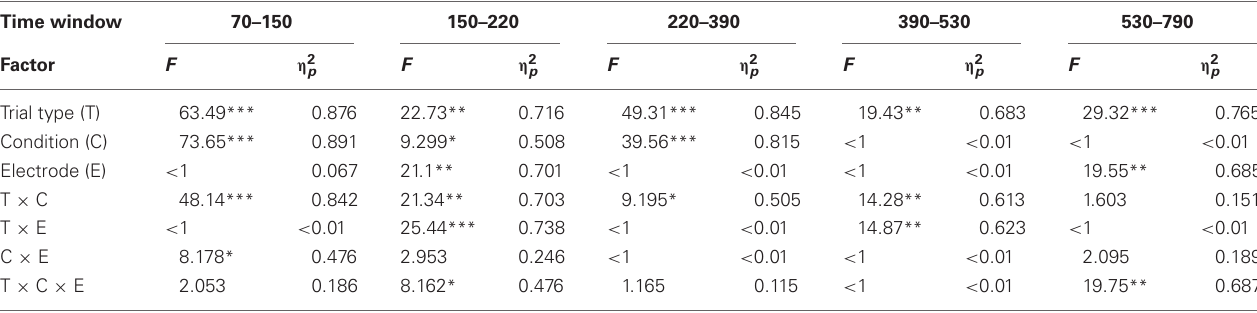
Table 2 | Statistical evaluation of effects of Trial type (rare vs. frequent), Condition (Oddball vs. Distractor), and Electrode (Fz vs. Cz) by means of repeated-measure ANOVAs separately for the five time windows in Experiment